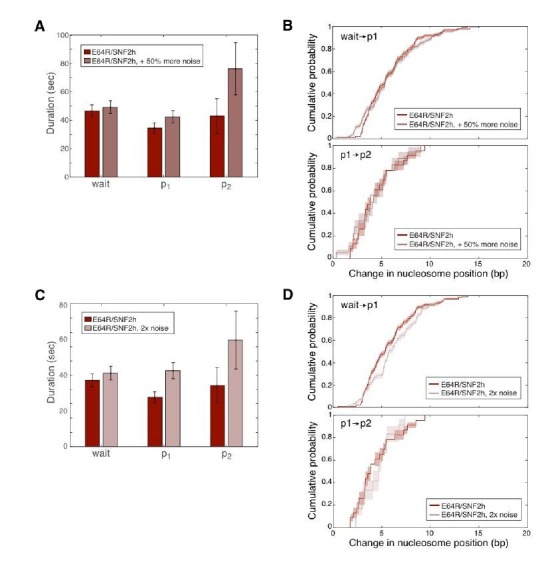
The addition of synthetic noise does not significantly change the outcome of our HMM fitting routine.Synthetic, uncorrelated, Gaussian-distributed noise was added independently to the Cy3 and Cy5 intensities for each E64R/WT trace, and then the pyhsmm analysis was re-run on these noisier data. Pause durations and changes in nucleosome positions (step sizes) were then re-computed and are here plotted as in Figure 3 in the main text. In A and B, the standard deviation of the added Gaussian noise was 0.4; in C and D, the standard deviation of the added noise was 0.6. The standard deviations of the original Cy3 and Cy5 intensity data were on average 0.5 and 0.3 respectively, so the data in A and B have about 50% more noise than the original data, while the data in C and D have about double the noise of the original data.